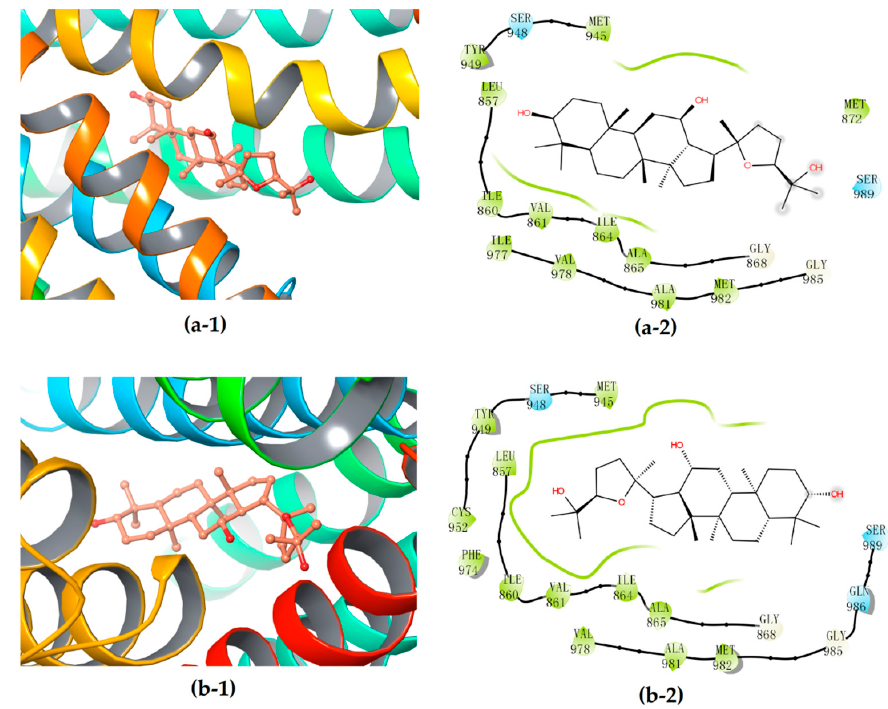
Figure 7. 3D ( 1 ) and 2D ( 2 ) diagrams illustrating the molecular interaction of 24 S -PDQ ( a ) and 24 R -epimer ( b ) with the P-gp. ( 1 ) The ball-stick structure: verapamil; the cartoon stuctures: P-gp. ( 2 ) White: glycine; green: hydrophobic; blue: polar.